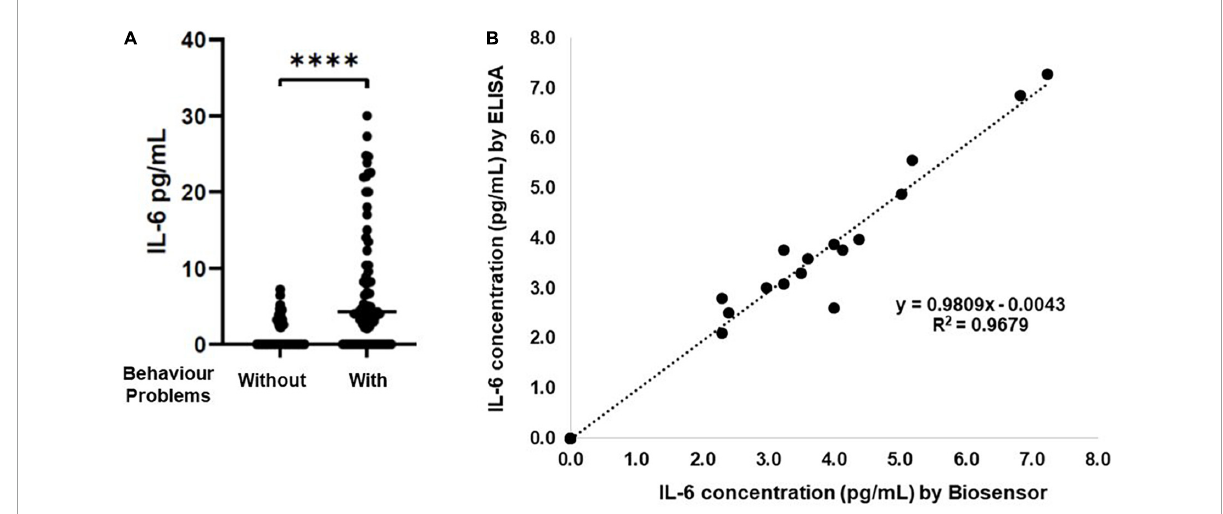
FIGURE4 Correlation between Immunosensor and ELISA results for detection of IL-6 in saliva samples. (A) Saliva samples from children’s with different behavior problems were analyzed by conventional ELISA assay ( n = 118). (B) Graphic representation of ELISA and immunosensor correlation. The dashed line shows the regression line with R 2 = 0.9679, **** p >